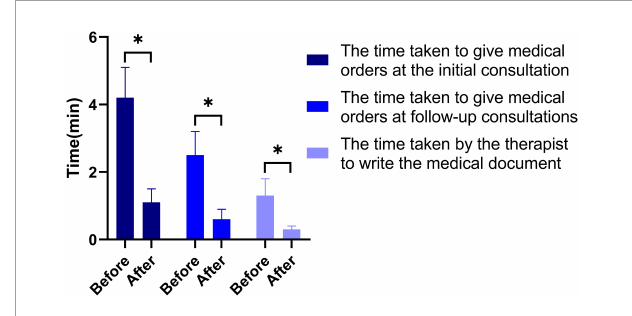
FIGURE4 Comparison of the time spent by doctors and therapists on daily medical records before and after project implementation. ∗ P <